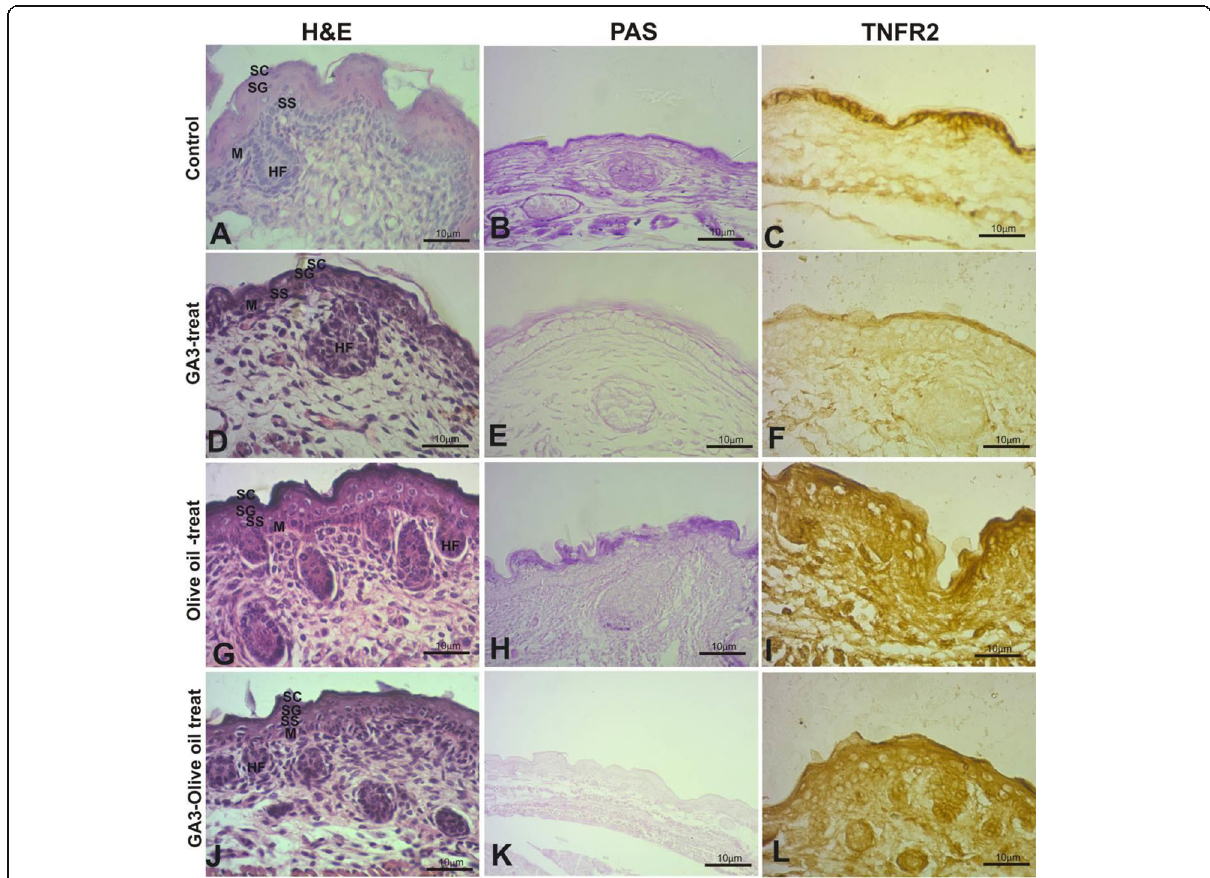
Fig. 9 Photomicrographs of H&E-, PAS-, and TNFR2-stained sections of developing skin at E18. The control skin contains Malpighian (M), stratum spinosum (SS), stratum granulosum (SG), stratum cornium (SC), and a well-developed hair follicle (HF) ( a ). PAS- and TNFR2-stained skin sections revealed localization of carbohydrates and TNFR2 expression in the epidermis ( b , c ). The skin of GA3-treated embryos showed a thin wrinkled epidermis, a less abundant and disorganized hair follicles with shrinkage of dermal papilla and decrease in PAS and TNFR2 expression in the epidermis ( d – f ). The skin of olive oil-treated embryo showed H&E and PAS staining similar to control, but high TNFR2 expression ( i ). The skin of GA3-olive oil-treated embryos showed improvement in the histopathological changes ( j – l ). Scale bar ( a – l ) = 10 μ